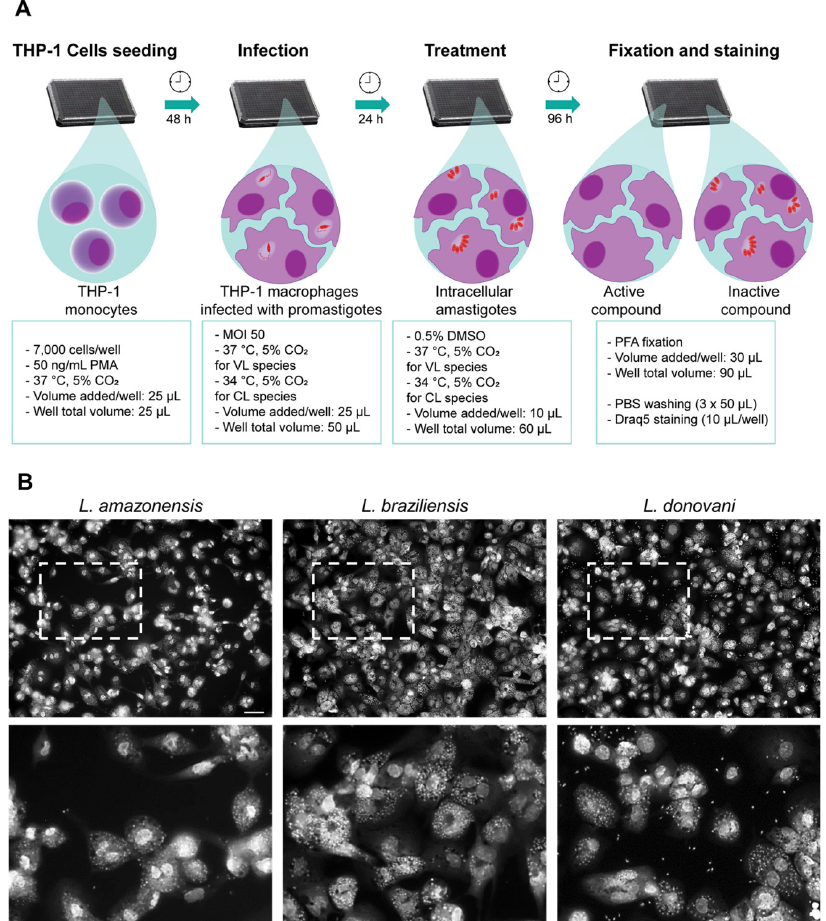
Figure 1. Leishmania high content assay. ( A ) Schematic representation of Leishmania multi-species high content assay. THP-1 cells were seeded and differentiated with phorbol 12-myristate 13-acetate (PMA) for 48 h, followed by infection with stationary-phase promastigotes. After another 24 h, compounds were added to infected cultures, and plates were incubated for 96 h. After this period, plates were fixed and stained. Images were acquired and processed in a High Content Screening instrument. VL, visceral leishmaniasis; CL, cutaneous leishmaniasis. ( B ) Representative images of Leishmania -infected THP-1 macrophages (multiplicity of infection (MOI) 50), 120 h post infection. Scale bar = 50 µm.